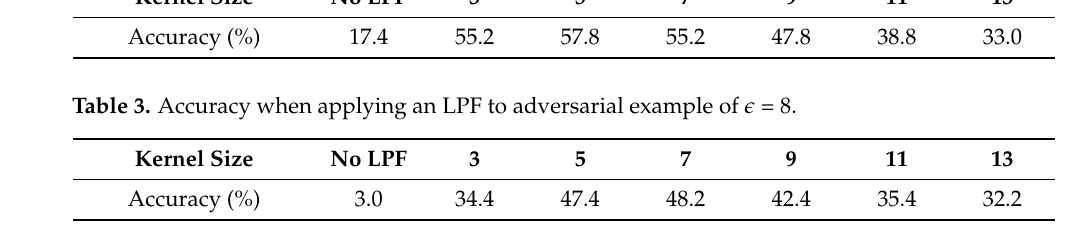
Table 2. Accuracy when applying an LPF to adversarial example of (cid:101) = 2. Kernel Size